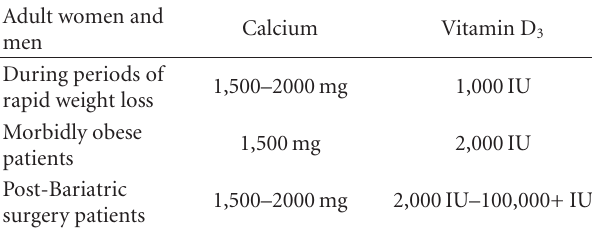
Table 1: Recommended daily calcium and vitamin D ∗ 3